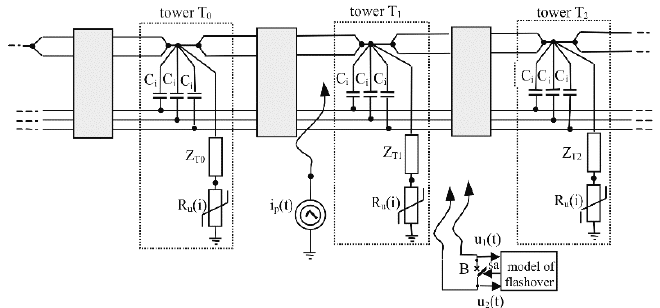
Figure 3. Model of overhead transmission lines with two shielding wires for simulation of the lightning overvoltages: I p —lightning current, Z Ti ( i = 0,1,2 ... ) —impedance of towers, R ui ( i = 0,1,2 ... ) —nonlinear resistance of earthing systems, C i —capacity of line insulators .